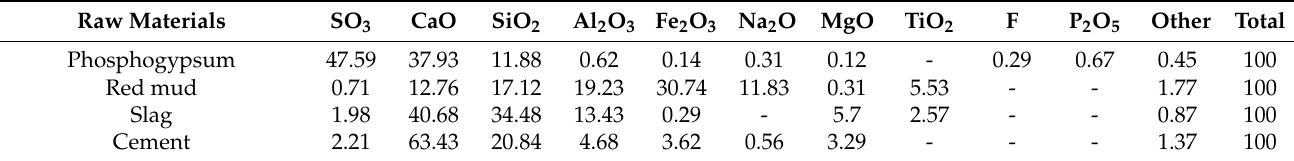
Table 1. Chemical compositions of raw materials (wt.